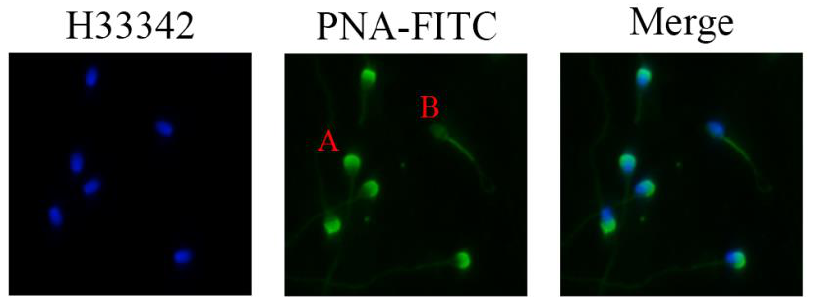
Figure 2. Assessment of sperm acrosome membrane integrity using fluorescein isothiocyanate- conjugated peanut agglutinin (FITC-PNA). Sperm with strong green fluorescence (A) considered acrosome intact; those with no fluorescence (B) considered acrosome damaged ( × 200 Magnification).